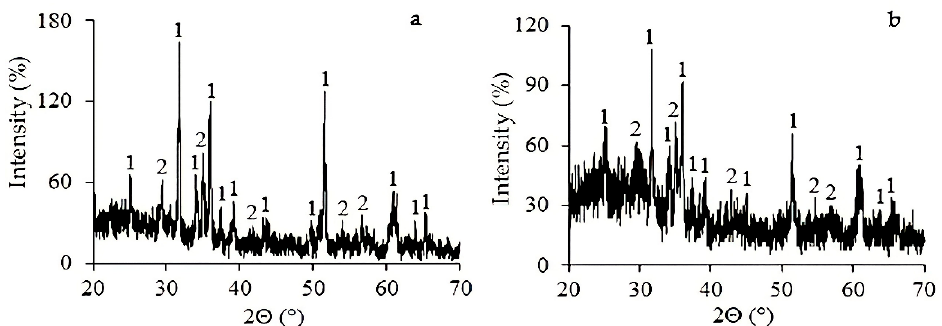
Figure 2. XRD patterns of slag samples varieties: ( a )—black color, ( b )—light gray color: 1—fayalite, 2—magnetite.